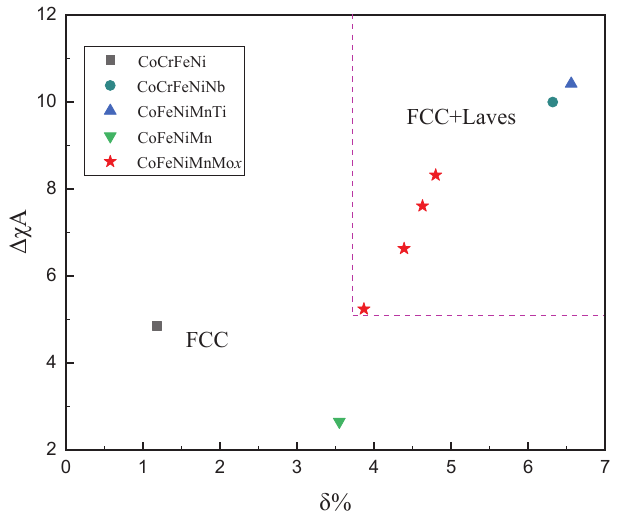
Figure 4. Plots of ∆ χ A vs. δ for predicting the evolution of FCC and Laves phase in the studied Figure 4. (cid:18)(cid:149)(cid:152)(cid:157)(cid:156)(cid:561)(cid:152)(cid:143)(cid:561)(cid:775) (cid:923) A vs. (cid:904) for predicting the evolution of FCC and Laves phase in the studied CoFeNiMnMo x ( x = 0.25, 0.5, 0.75 and 1.0) alloys and other reported HEAs CoFeNiMnMo x ( x = 0.25, 0.5, 0.75 and 1.0) alloys and other reported HEAs [14,15,22].